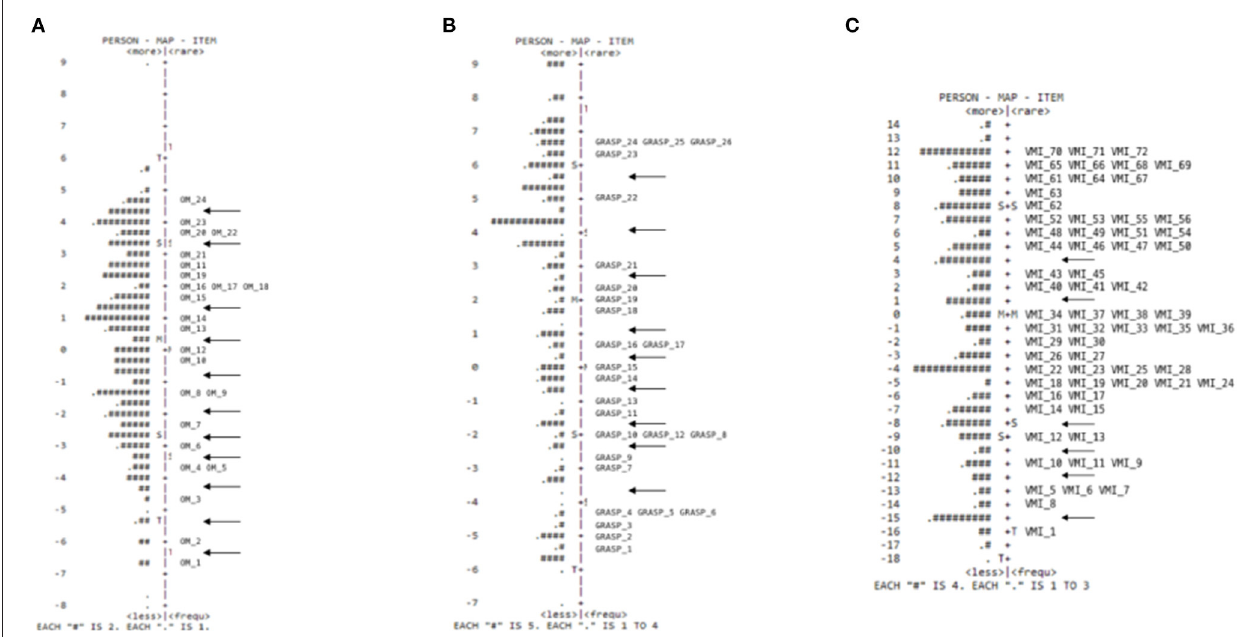
FIGURE 2 | Person item map of the object manipulation (A) , grasping (B) , and visual-motor integration (C)